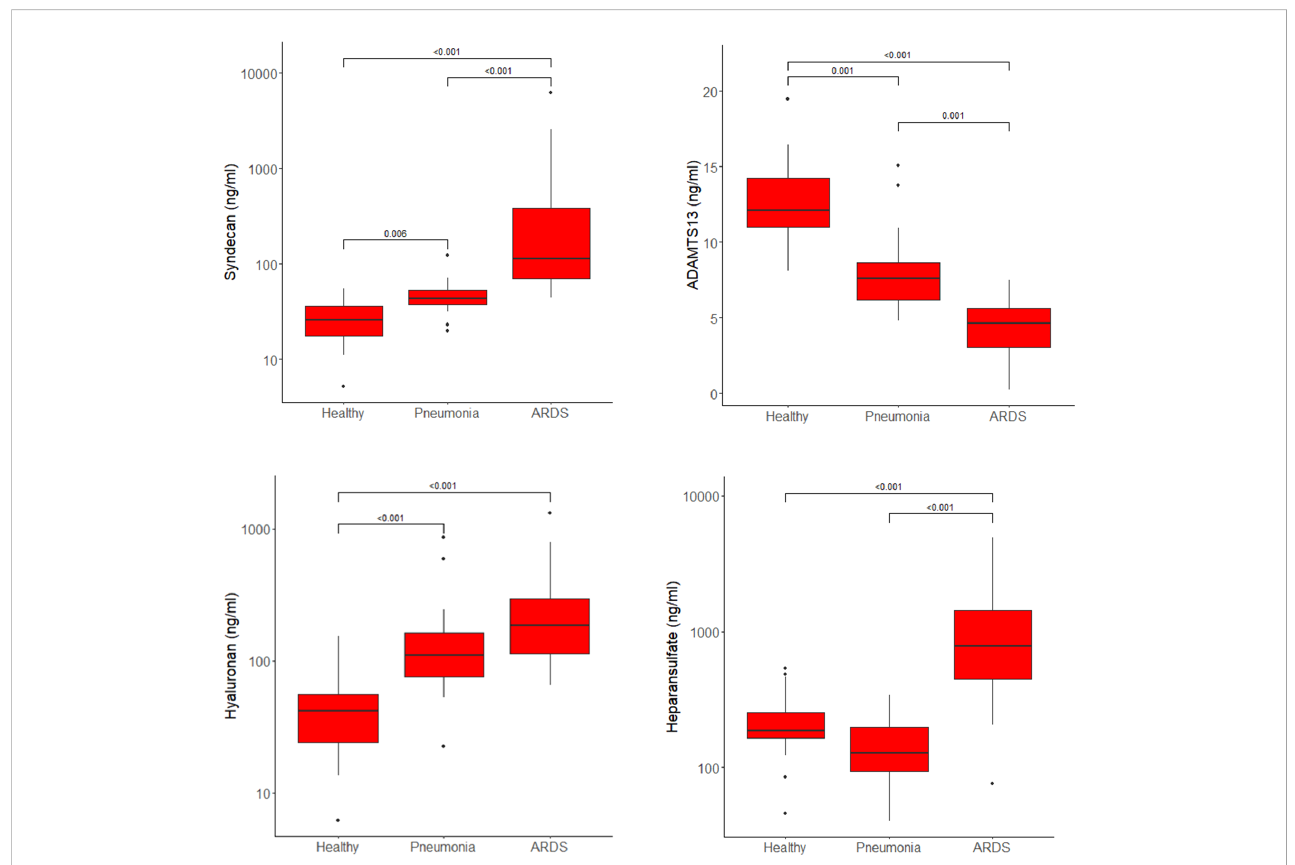
FIGURE 2 Plasma concentrations of syndecan-1, ADAMTS13, hyaluronic acid and heparan sulfate in healthy controls, patients with COVID-19 pneumonia and those who progressed to ARDS presented as boxplots. Horizontal lines across the boxes show signi fi cant differences with p-values between groups. Boxes represent Q1 and Q3 with median in between. Whiskers are Q1-1.5*IQR and Q3+1.5*IQR. Outliers are shown as